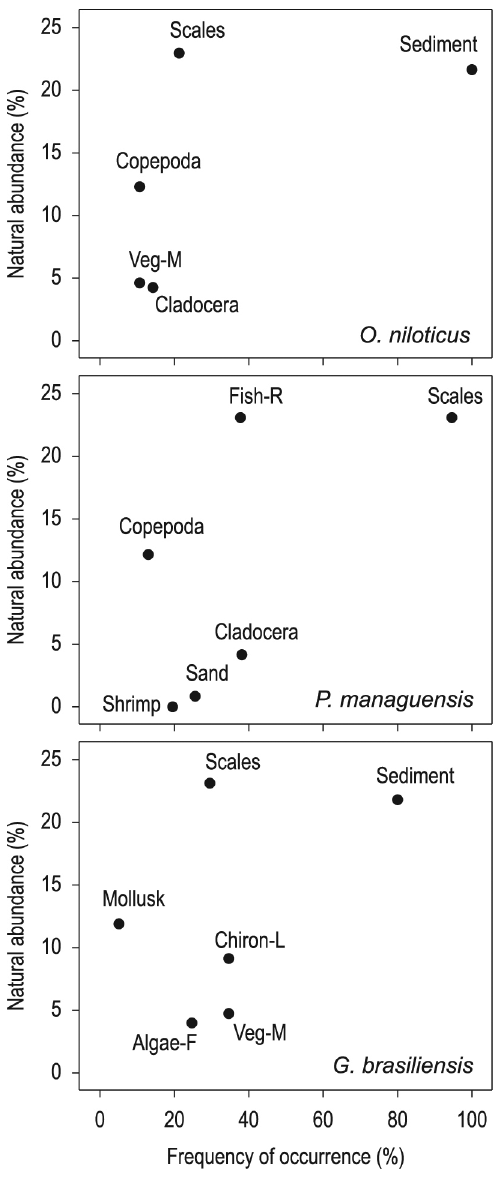
Figure 3. The feeding strategy diagram of food items natural abundance (%) plotted against frequency of occurrence (%) of food items in the stomach contents of the study species (modified from Amundsen et al. (1996)).